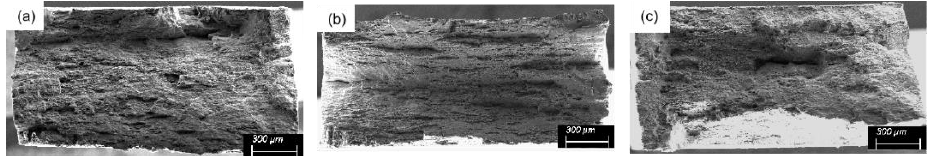
Figure 10. Macro-tensile fracture morphology of asymmetric rolled 1.5 mm plate: ( a ) 45° direction, ( b ) RD direction, and ( c ) TD direction.